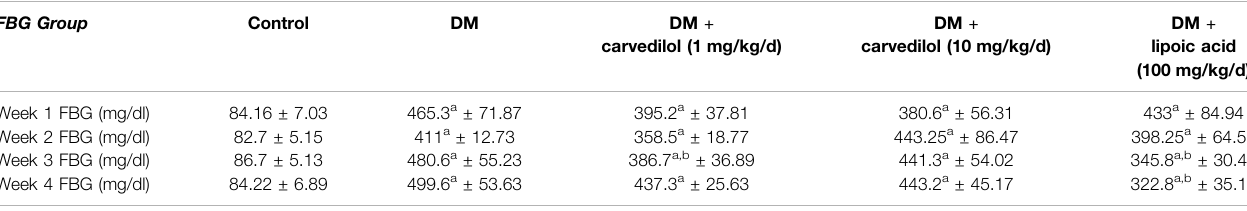
TABLE 1 | Effect of carvedilol on FBG levels in STZ-induced diabetes in rats. FBG Group